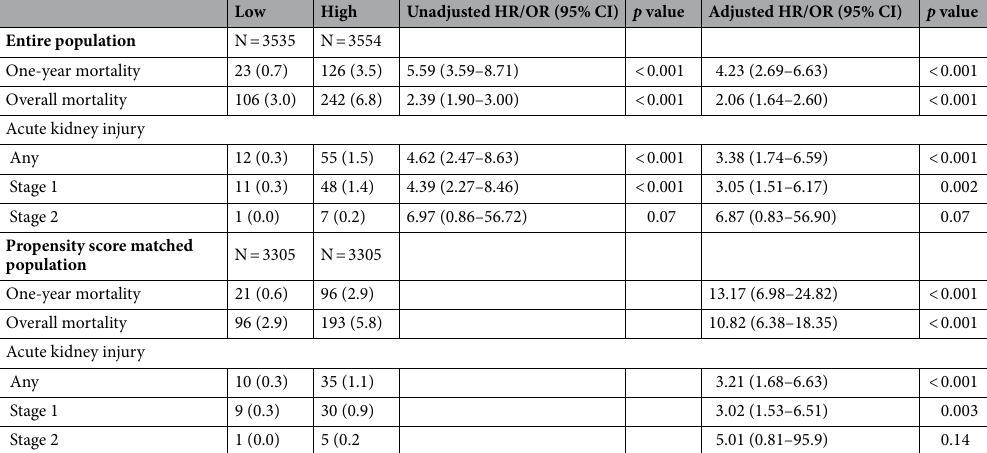
Table 2. Clinical outcomes according to the median value of preoperative NLR. Mortalities were reported with HR, and acute kidney injury was reported with OR. Multivariable analysis retained age, male, alcohol, preoperative creatinine level, Charlson comorbidity index, operative duration, and general anesthesia. Propensity score matching analysis retained age, male, smoking, alcohol, preoperative creatinine/hemoglobin levels, hypertension, Charlson comorbidity index, operative duration, and general anesthesia. NLR neutrophil- to-lymphocyte ratio, HR hazard ratio, OR odds ratio.